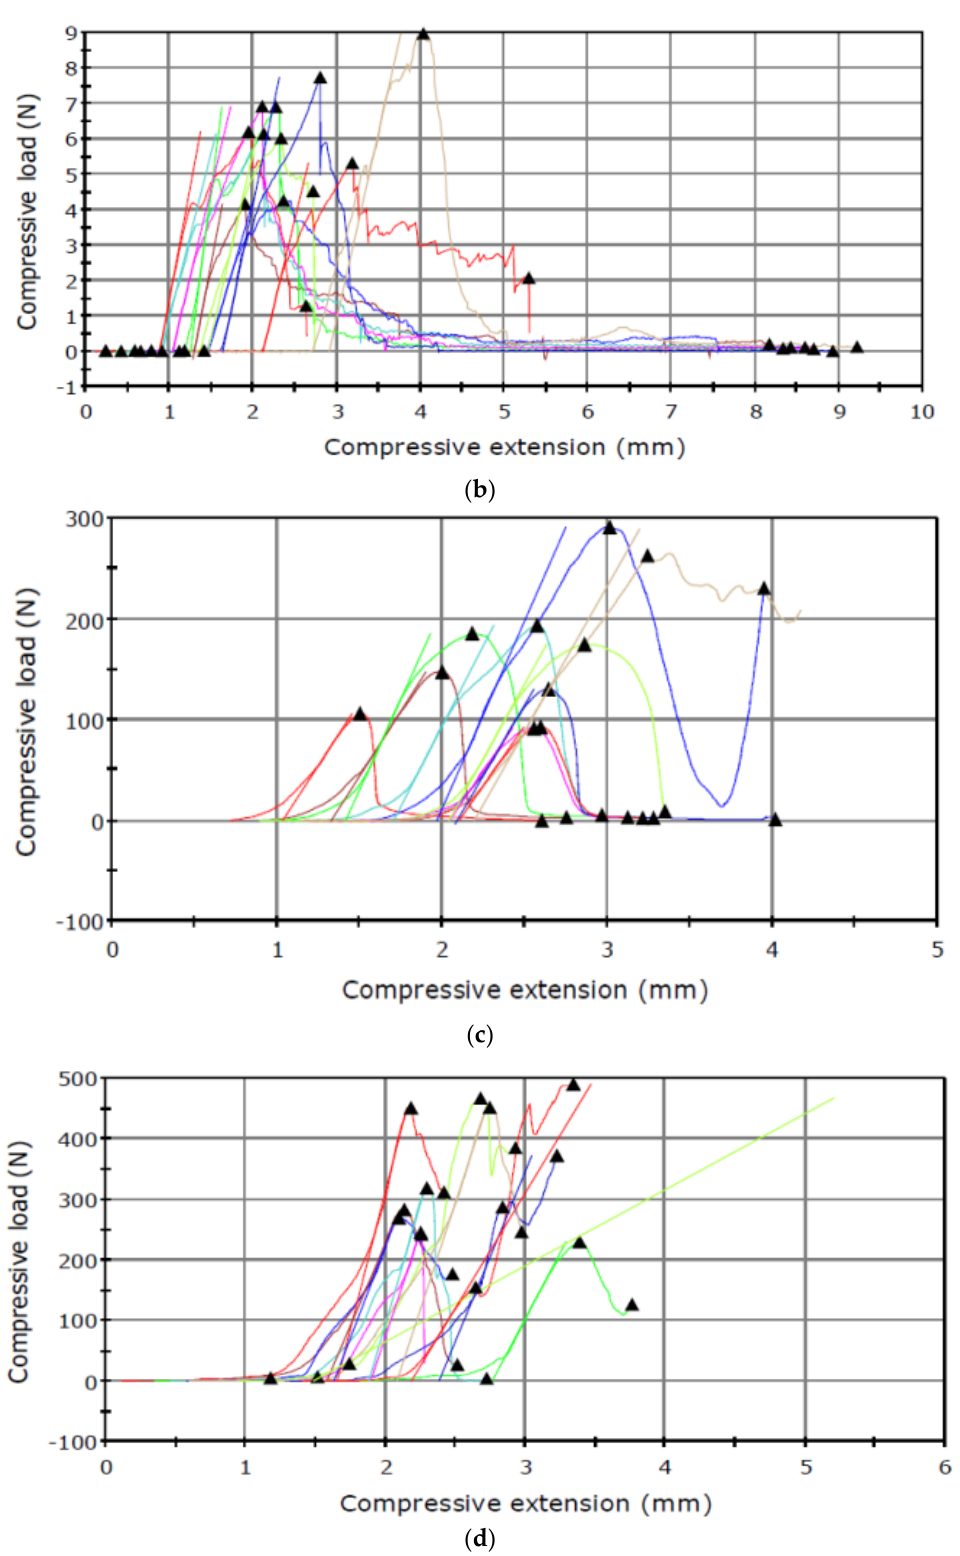
Figure 3. Puncture test carried out in September for the seed capsule of ( a ) I. aphylla and ( b ) I. sibirica and for the seeds of ( c ) I. aphylla and ( d ) I. sibirica . I. aphylla and ( d ) I. sibirica